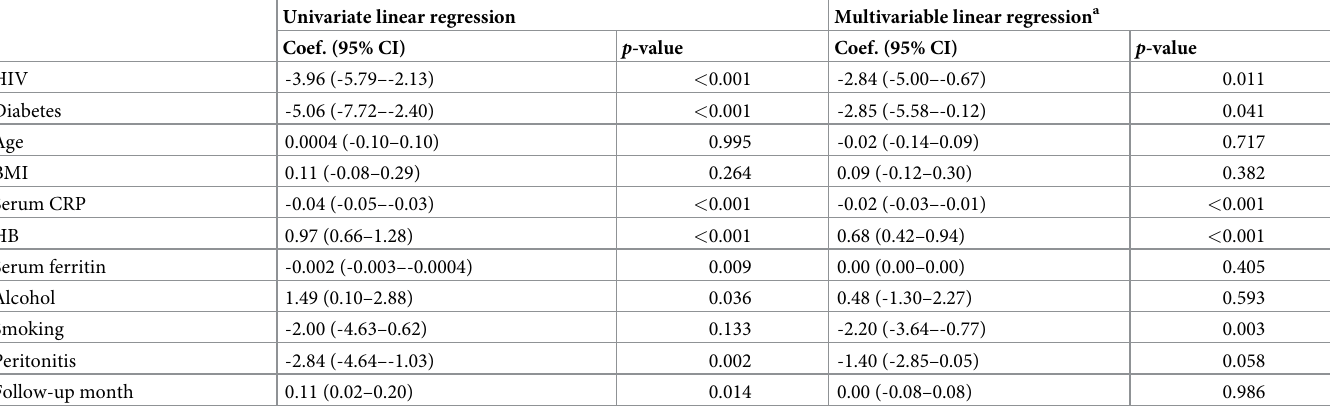
Table 4. Univariate and multivariable clustered linear regression analysis of monthly average serum